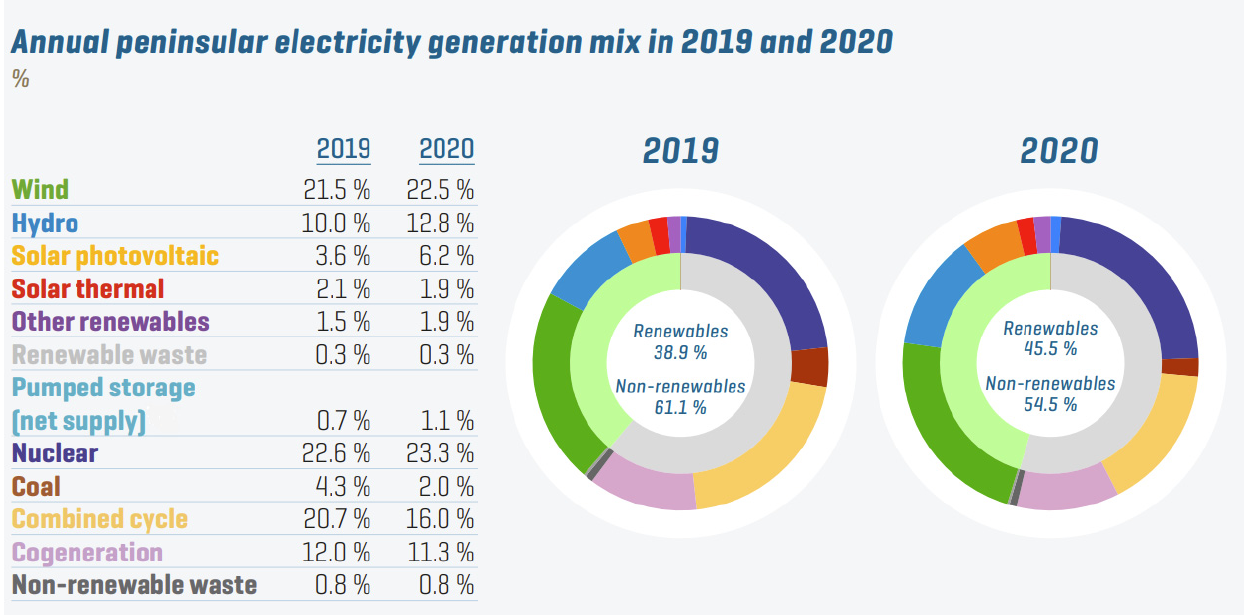
Figure 1. Peninsular Spain electricity generation mix in 2019 and 2020 (%) [7].